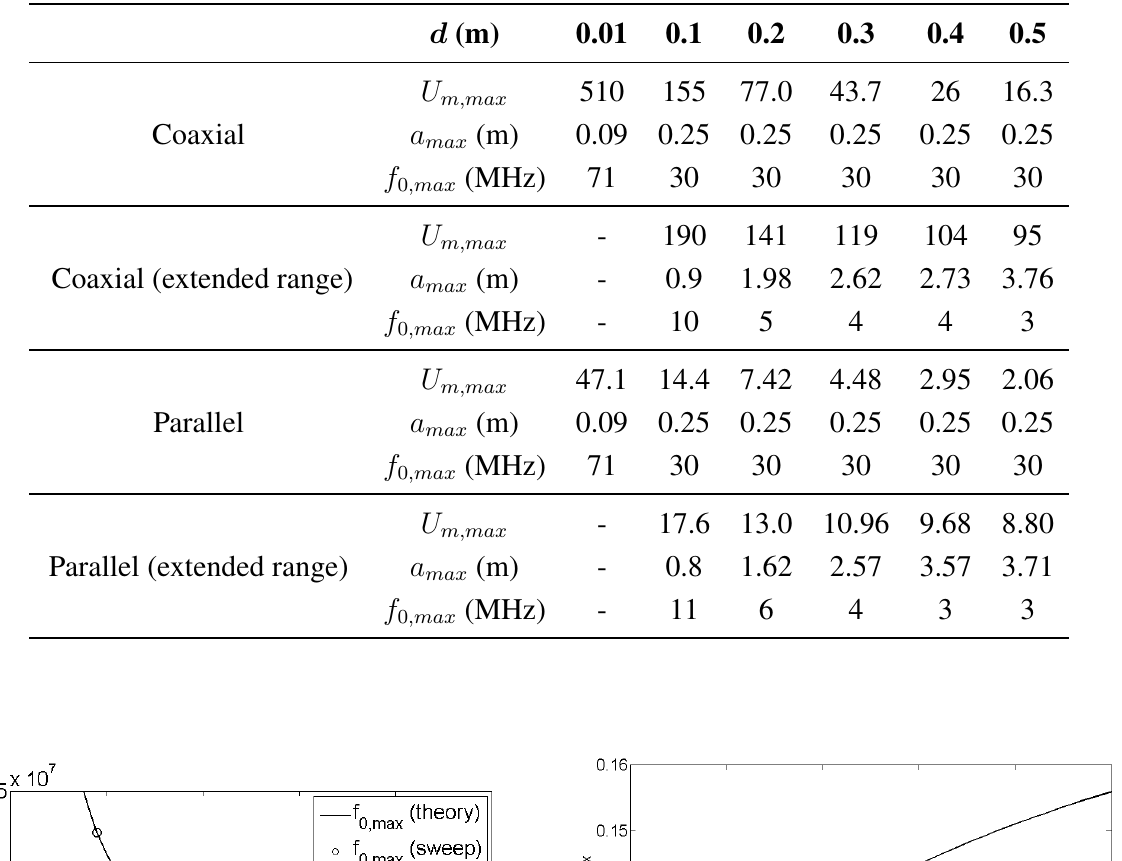
Table 1. Maximum figure of merit values, U system.